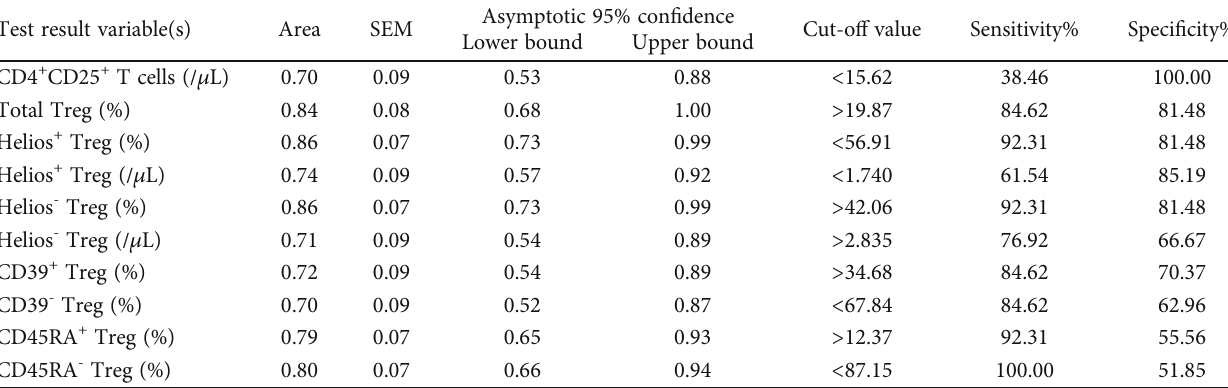
SEM: standard error of